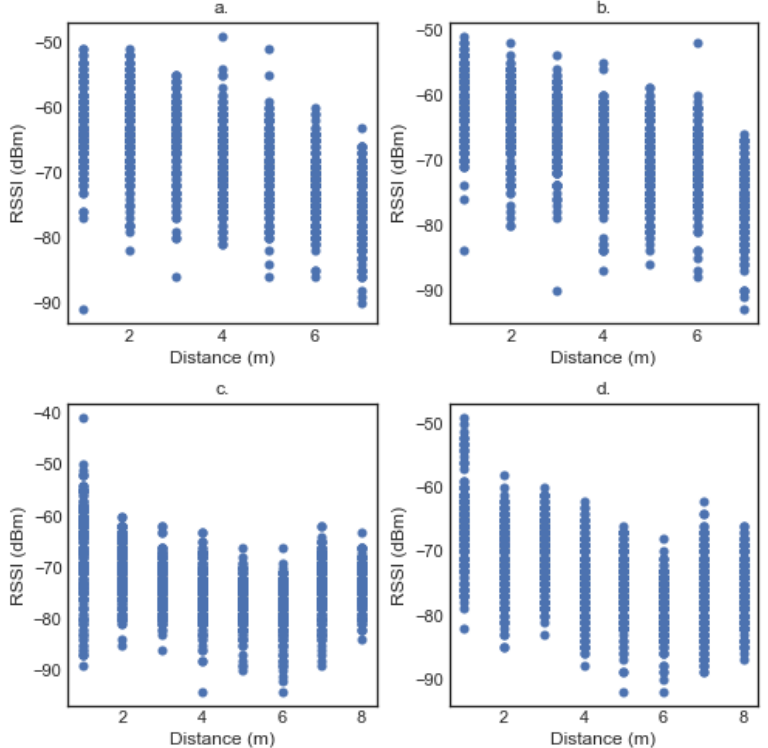
Figure 3. ( a ) Scatter Plots of band 2 in the hall. ( b ) Scatter Plots of band 3 in the hall. ( c ) Scatter Plots of band 2 in outdoors. ( d ) Scatter Plots of band 3 in